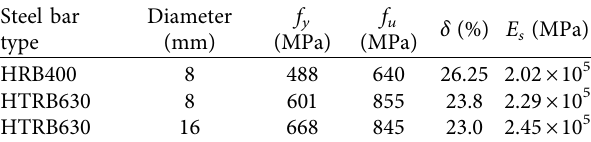
Table 3: Mechanical properties of reinforced bars.